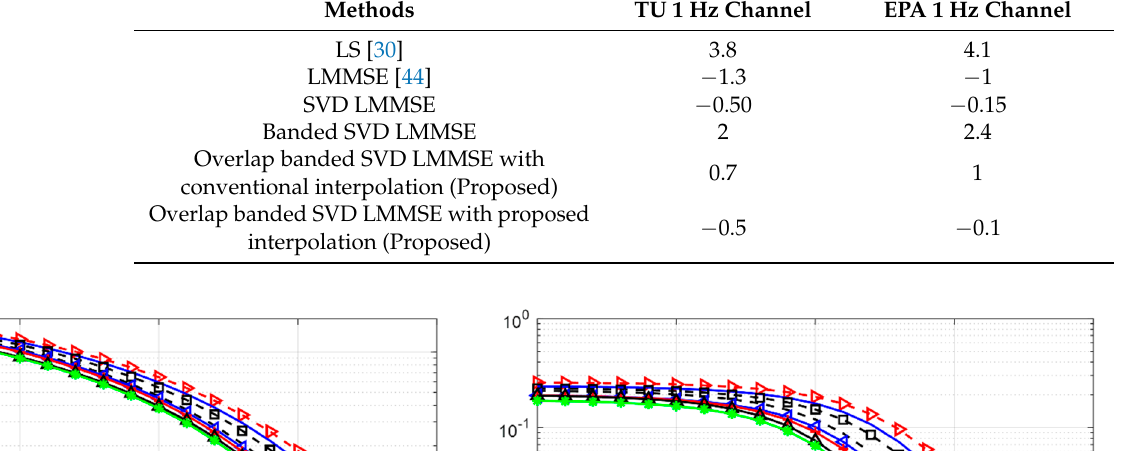
Table 5. Received SNR (dB) at BER = 10 − 2 for different channel estimators.